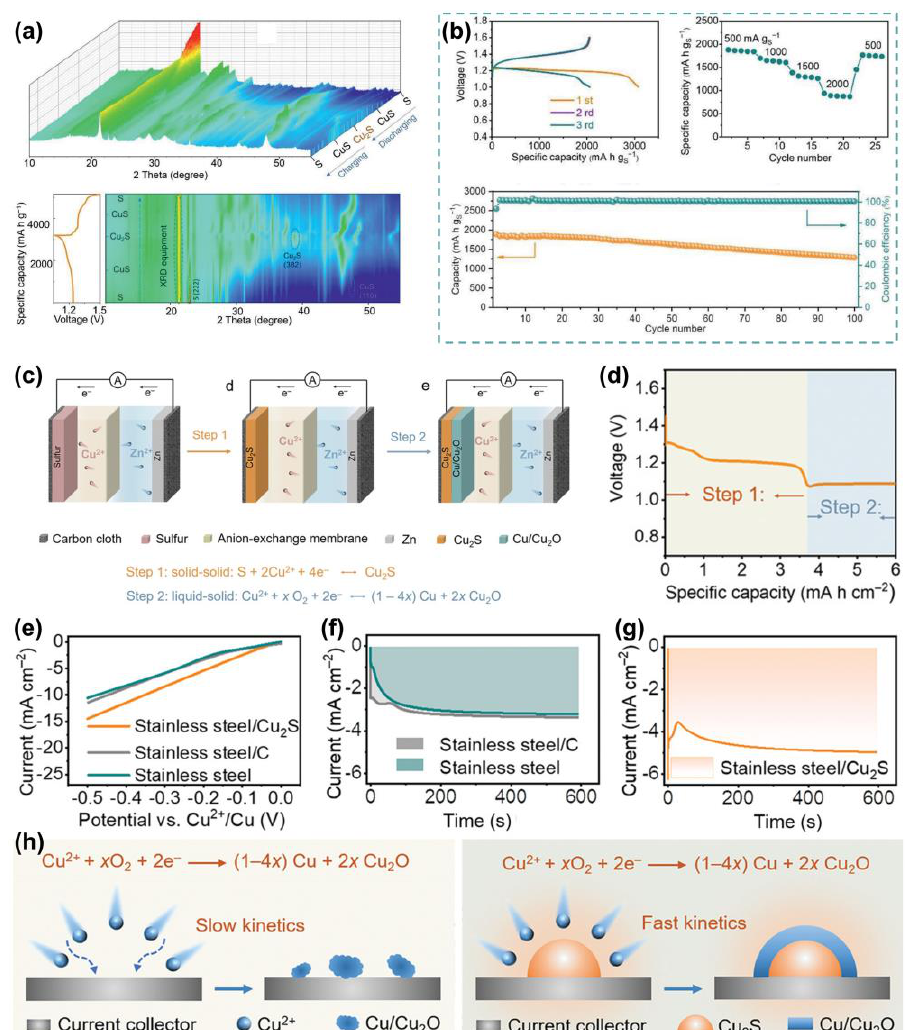
Figure 6. ( a ) In situ XRD patterns and ( b ) initial three GCD curves, rate and cycling performance of the hybrid AZSBs (reproduced with permission from Ref. [62]. Copyright 2021, Wiley-VCH). ( c ) Working mechanisms and ( d ) the typical discharge curve of ACB; ( e ) LSV curves and ( f , g ) potentiostatic deposition curves of different current collectors; ( h ) schematic of Cu/Cu 2 O deposited on the bare current collector and Cu 2 S, respectively (reproduced with permission from Ref. [84]. Copyright 2021,